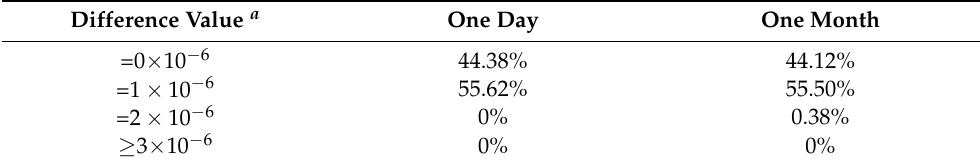
Table 1. Statistical result (percentage) for time-tag (GPS time) differences between ours and the official one. The unit of time difference is